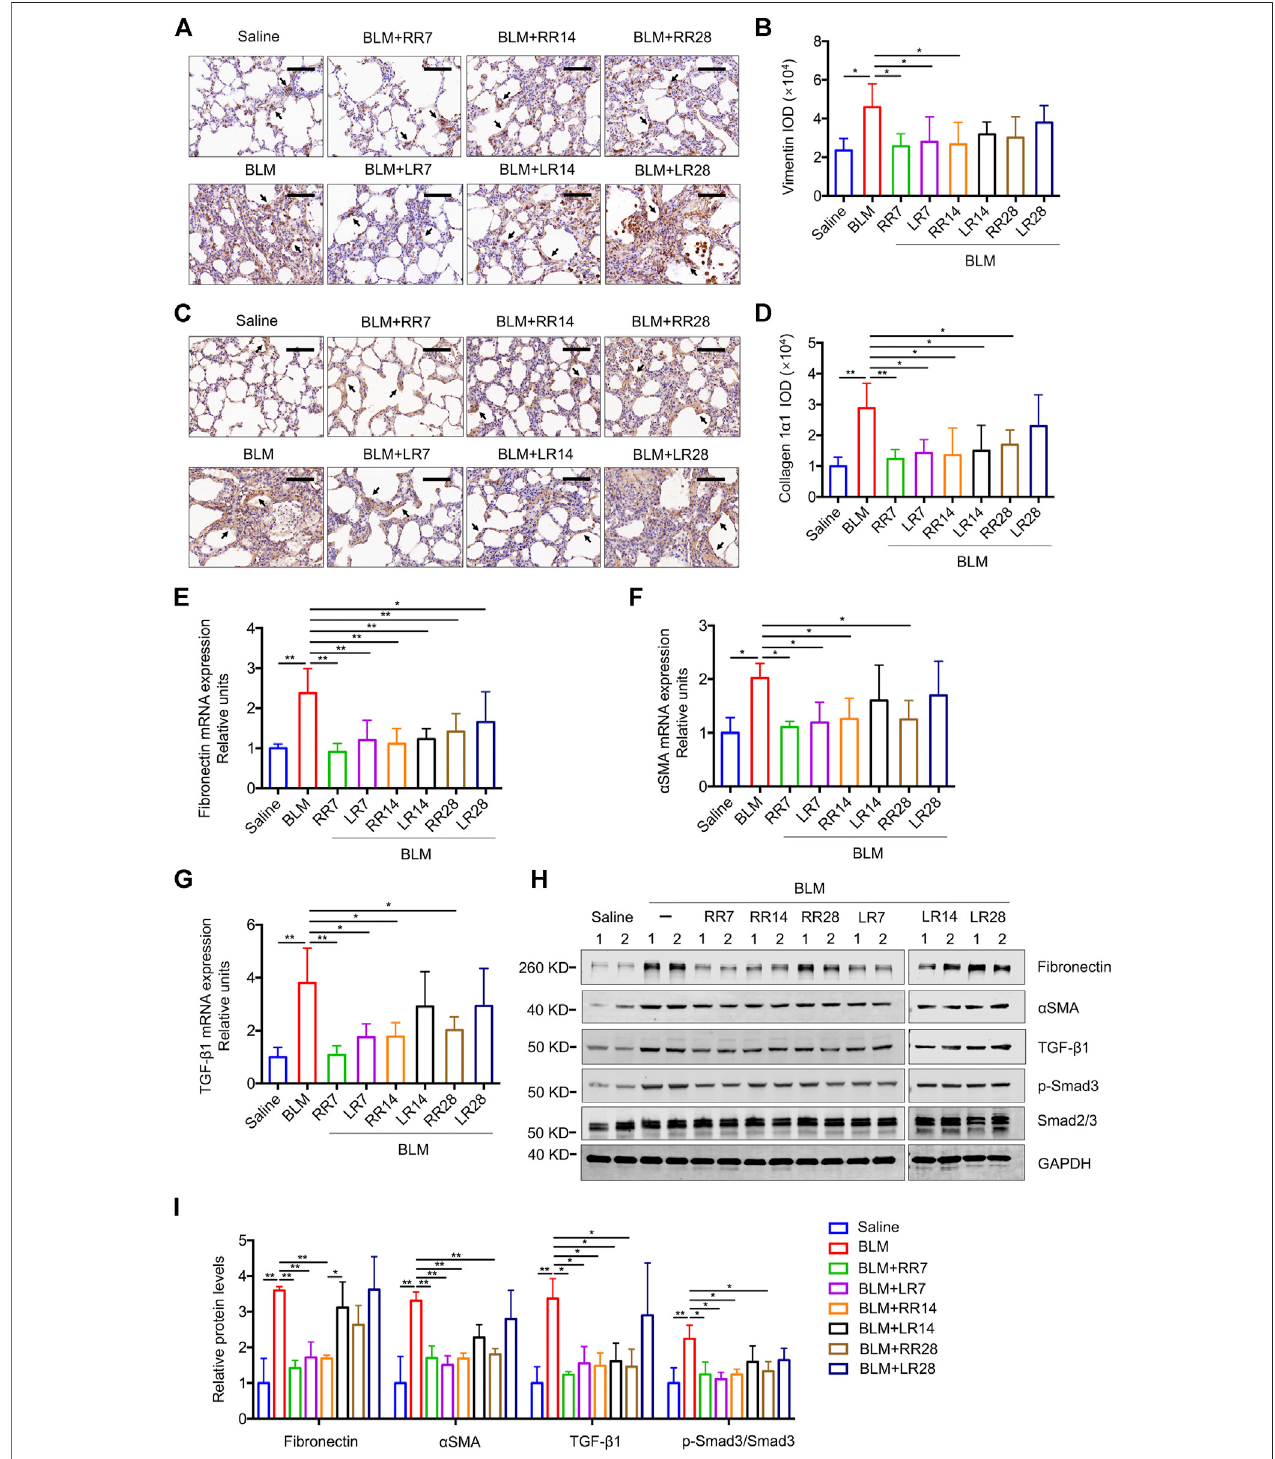
FIGURE4| Microcystin-RR(MC-RR)showsabettereffectonreducingtheexpressionlevelsof fi broticmarkersthanMicrocystin-LR(MC-LR).Ratsweretreatedas explained in Figure 3 . (A) Representative immunohistochemical staining of vimentin in rat lung tissue sections. Scale bar: 100 μ m. Black arrows indicate vimentin- positive cells. (B) The expression of vimentin was quanti fi ed by integrated optical density (IOD) using Image-Pro Plus 6.0 software. (C) Representative immunohistochemical staining of collagen 1 α 1 in rat lung tissues. Scale bar: 100 μ m. Black arrows indicate collagen 1 α 1-positive cells. (D) Quanti fi cation of collagen 1 α 1 was performed by IOD. (E – G) The mRNA was puri fi ed from pulmonary tissues and examined for the expression of fi brotic markers, including fi bronectin, α -smooth muscle actin ( α SMA) and transforming growth factor- β 1 (TGF- β 1). (H,I) Protein levels in rat lung tissues were measured by western blot and quanti fi ed. Data are presented as mean ± SD. * p < 0.05, ** p < 0.01 determined by one-way ANOVA with S-N-K post-hoc analysis. Each group had fi ve rats.